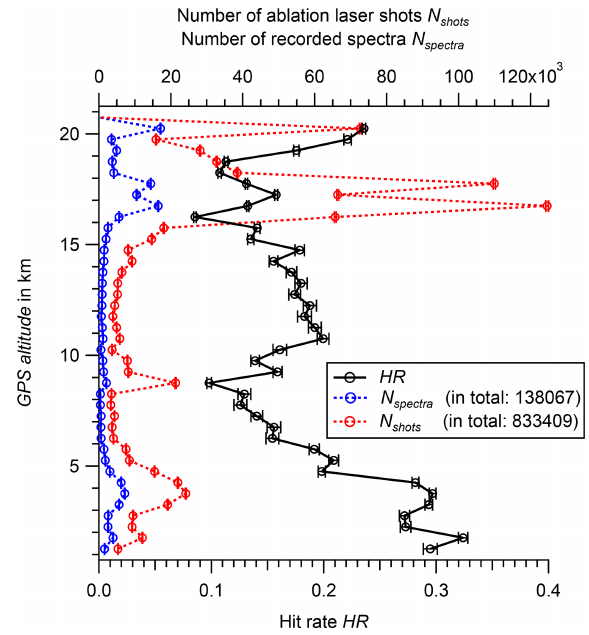
Figure 14. Vertical profile of the hit rate HR (black, bottom ab- scissa), the number of recorded spectra N spectra (blue, top abscissa), and number of ablation laser shots N shots (red, top abscissa) for the entire second aircraft campaign in 500m bins. Uncertainties in HR, N spectra , and N shots are based on counting